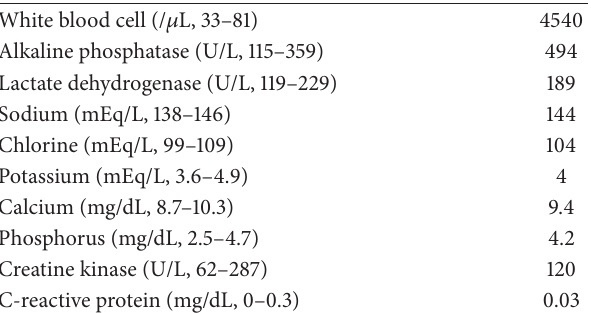
Figure 2: A 1-year follow-up reconstructed computed tomography (CT) scan of the lumbar spine after initial conservative treatment. (a) Right parasagittal reconstructed CT image. (b) Left parasagittal reconstructed CT image. (c) Axial CT image at L5 level. The radiological findings indicated that the bilateral spondylolysis of the L5 had united (a, b, c). Table 1: Laboratory